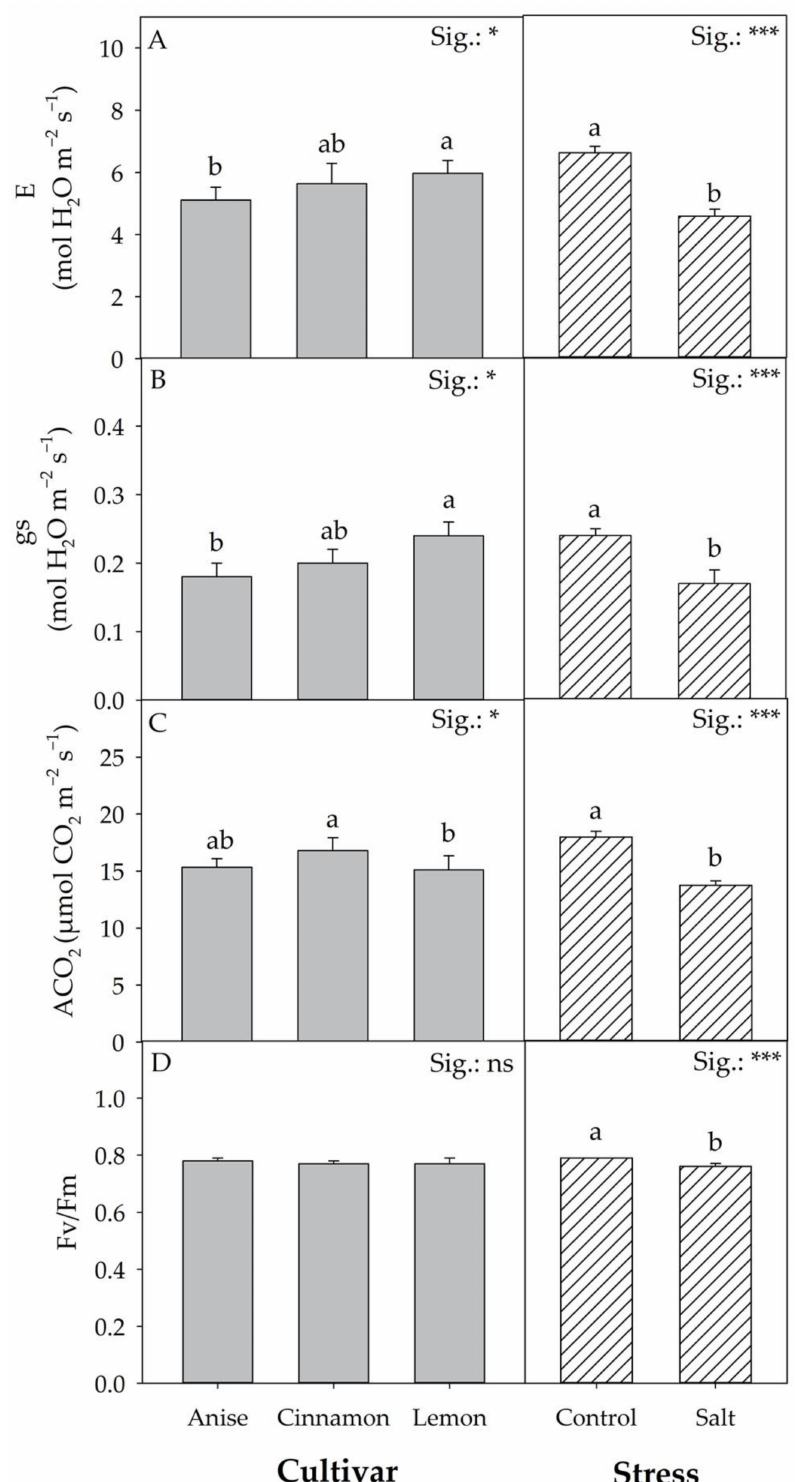
Figure 4. Effect of Cultivar and Stress on transpiration ( A ), stomatal conductance ( B ), net CO 2 assimilation rate ( C ), and chlorophyll fluorescence ( D ). Data are mean values ± standard error, n = 3. Mean comparisons were performed by Tukey HSD test for Cultivar and by t -Test for Stress. Different letters indicate significant mean differences. ns, *, and *** denote non-significant or significant effects at p ≤ 0.05 and 0.001,